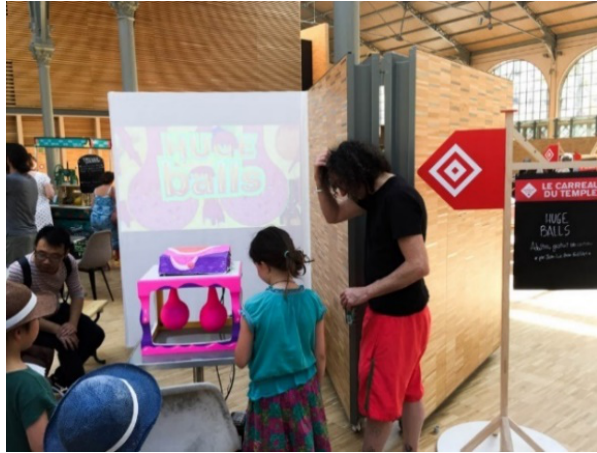
Figure 1. Huge balls version.2 in the exhibition Malakoniarof in Malakoff,